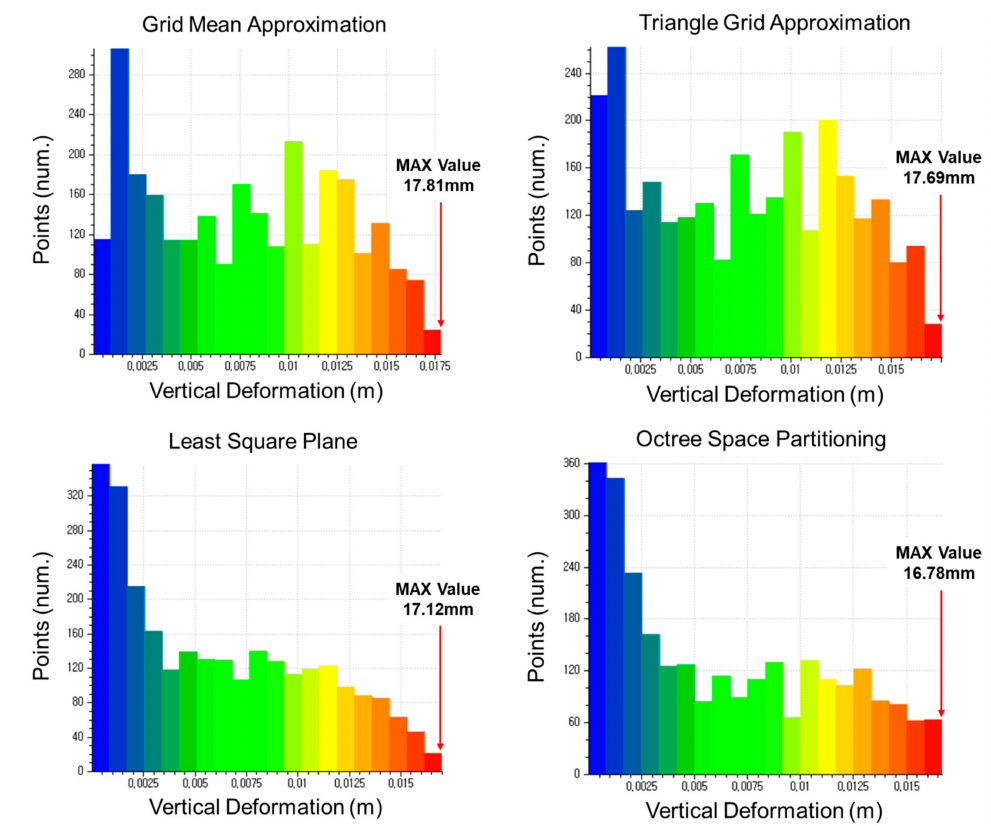
Figure 7. Classification of vertical displacement of the 8 mm specimen (LC4).